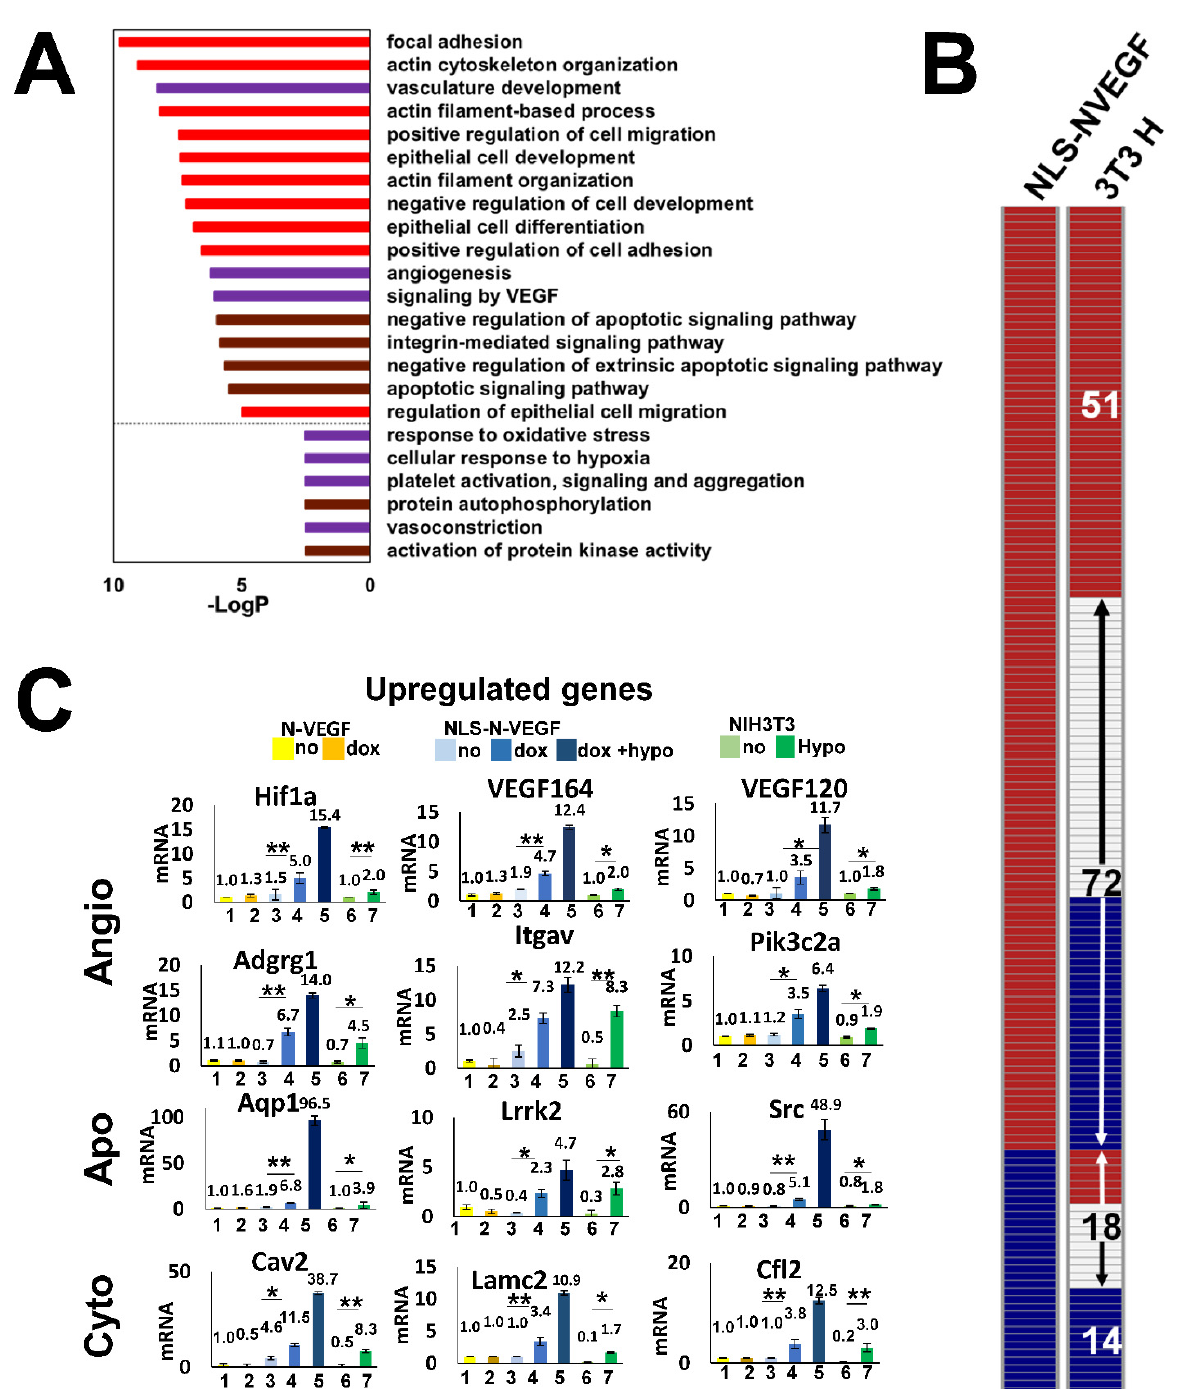
Figure 2. Transcriptional impact of hypoxia-independent mobilization of N-VEGF to the nucleus. ( A ) The top gene ontology terms of the 123 genes upregulated when N-VEGF is shuttled to the nucleus. Bars below the dashed line are not statistically significant. ( B ) Qualitative comparison between 155 differentially expressed genes following mobilization of N-VEGF to the nucleus and their expression trend in wild type cells exposed to hypoxia. The columns represent a qualitative heatmap showing the direction of change in gene expression level (up-red, down-blue, no change-white) in NLS-N-VEGF cells following dox treatment (NLS-N-VEGF, left column) in comparison to NIH3T3 cell under hypoxia (3T3 H, right column). The numbers within the right column represent the number of genes in each group that were annotated (detailed annotations in Figure S5A–D). ( C ) Validation of RNA seq results using qPCR. Real-time RT-qPCR analyses were performed on select upregulated genes from each